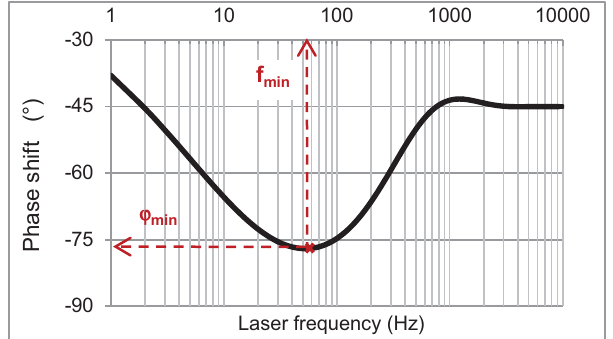
Fig. 2. Phase shift for SS 304L plate of 400 m